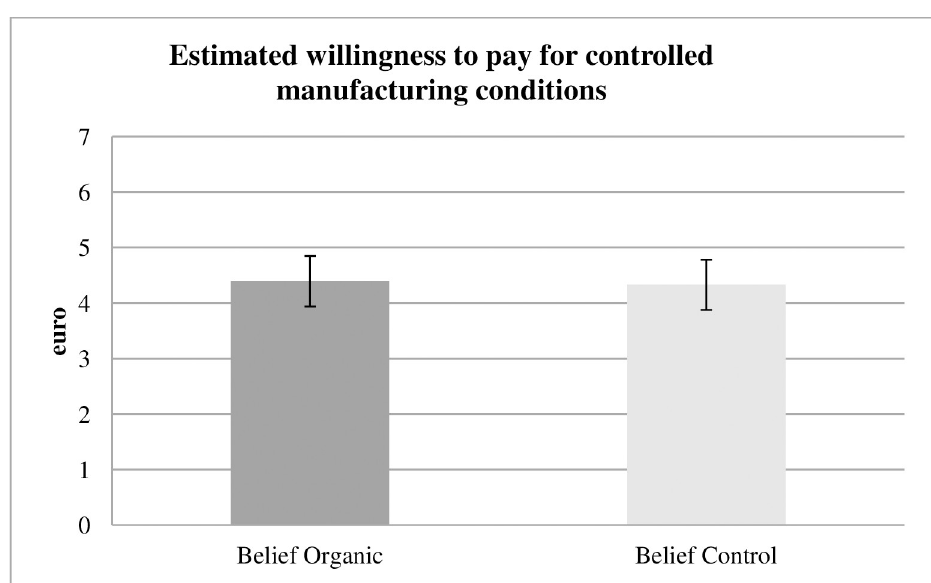
Fig 3. Estimated WTP belief treatments. In the Belief treatments, subjects guess the average WTP for controlled manufacturing in Product Organic, resp. Product Control. The data displays no significant difference in estimates at any conventional level. Thus, subjects in Belief Organic are not aware that static moral self-licensing may take place.